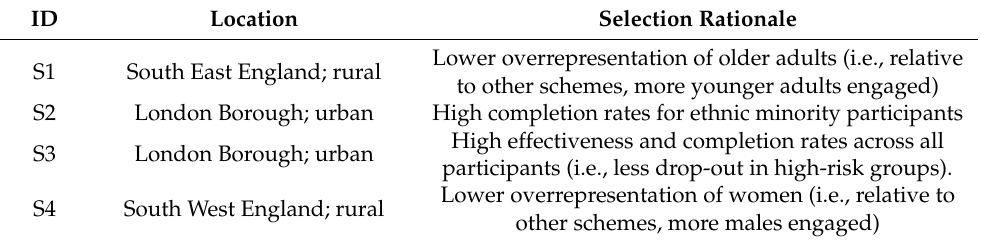
Table 3. Outcomes of scheme completion (DV = change in